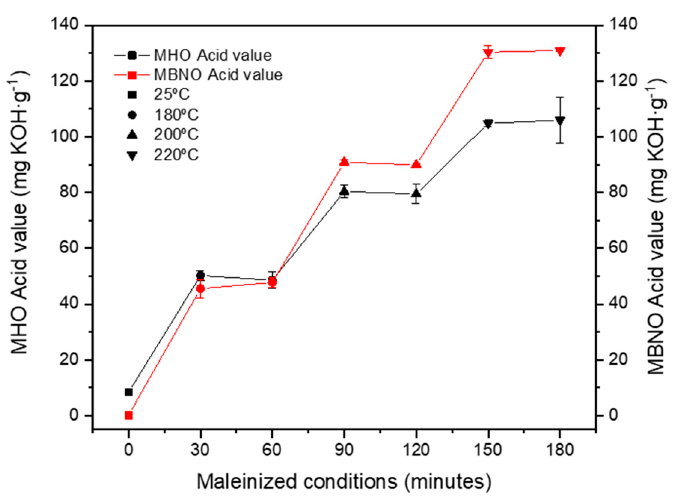
Figure 2. Effect of temperature and time on the efficiency of the maleinization of HO and BNO with maleic anhydride.